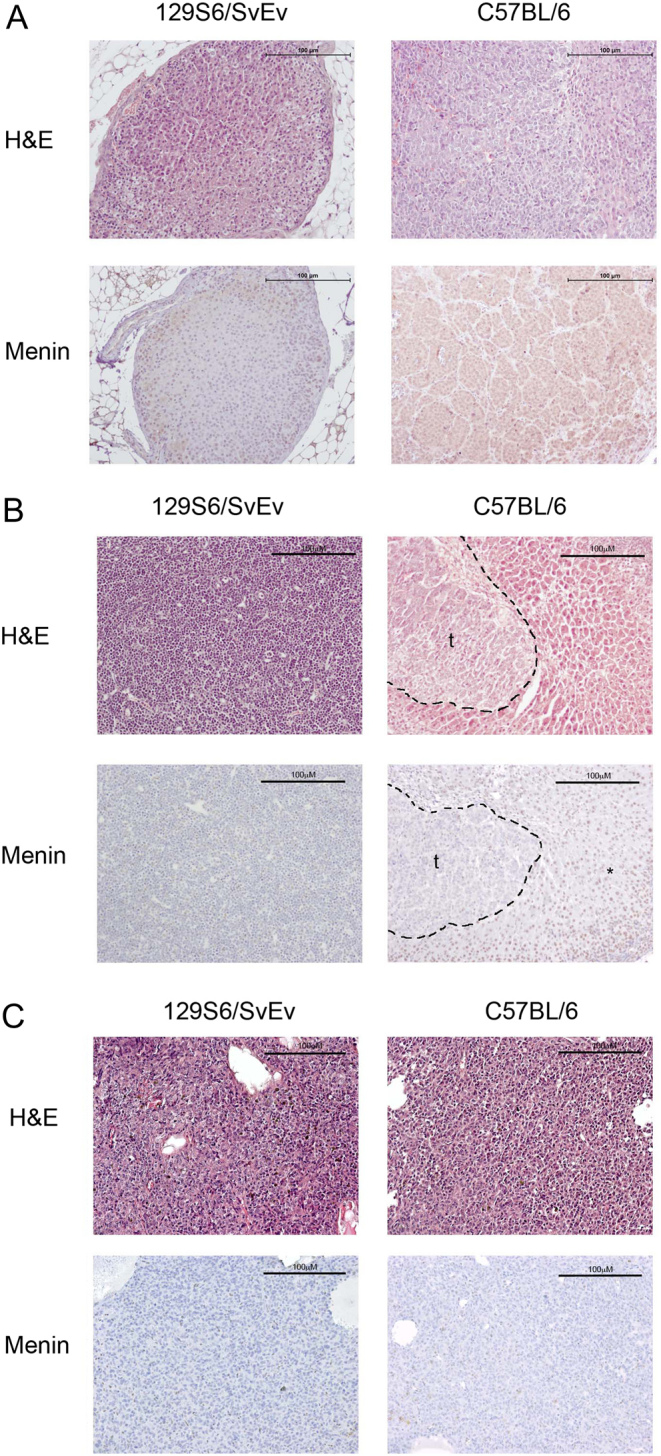
Histological and immunohistochemical analysis of adrenal, ovarian and testicular tumours from congenic Men1+/- mice. (A) Adrenal cortical tumours from 23-month-old male 129S6/SvEv Men1+/- and C57BL/6 Men1+/- mice were stained with haematoxylin and eosin (H&E) and for menin. In both strains, menin expression was lost in the tumours. The scale bar represents 100 μM. (B) Ovarian tumours from 18-month-old female Men1+/- 129S6/SvEv and C57BL/6 mice were stained with H&E and menin. Menin, identified by brown nuclear DAB staining (*), was lost in the tumours (t) and retained in the surrounding normal tissue. The scale bar represents 100 μM. (C) Testicular tumours from 18-month-old male Men1+/- 129S6/SvEv and C57BL/6 mice were stained with H&E and menin. In both strains, menin expression was lost in the tumours. The scale bar represents 100 μM.